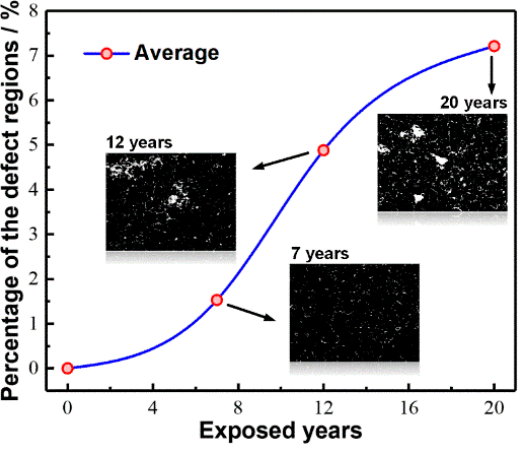
Figure 9. Percentage of regions of defect in the macroscopically visible intact area of the surface coatings subjected to different durations of exposure.